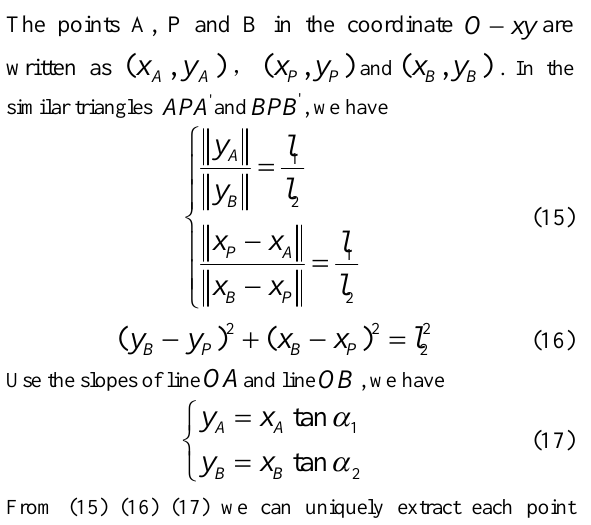
Fig. 3. The O- xy coordinate